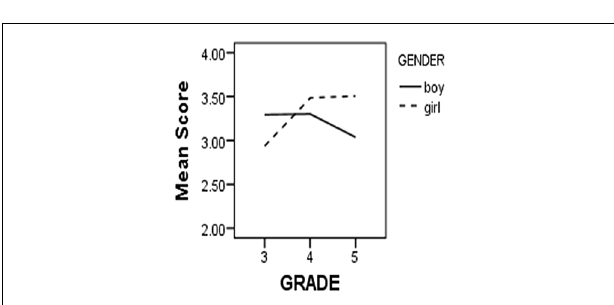
FIGURE 2 | Past dimension of children’s mind